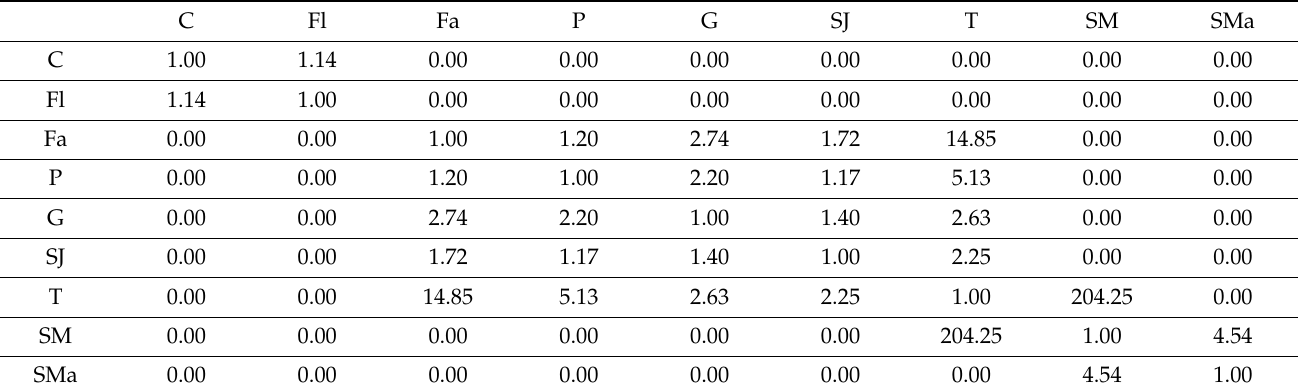
Table 11. Ratio of the correlation matrices for the best models for MIE and SIE species of the Azores. The abbreviations mean: C—Corvo, Fl—Flores, Fa—Faial, P—Pico, G—Graciosa, SJ—S ã o Jorge,